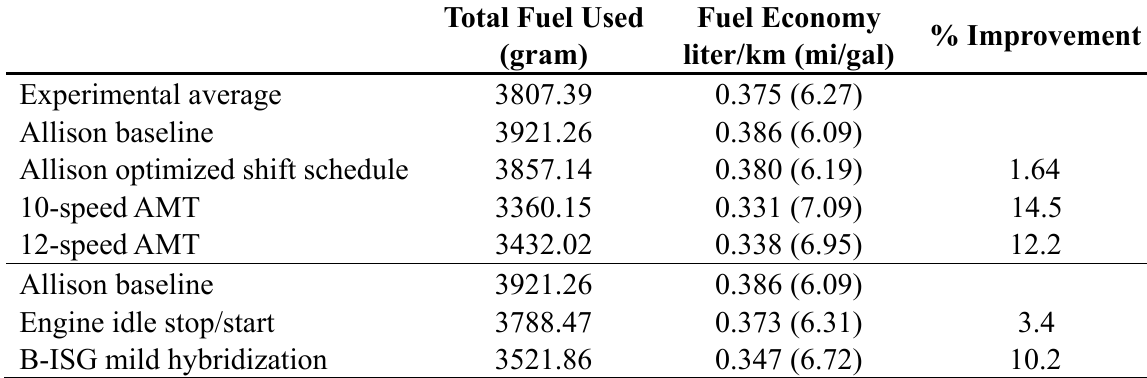
Table 5. Comparison of fuel economy over the FTP-72 drive